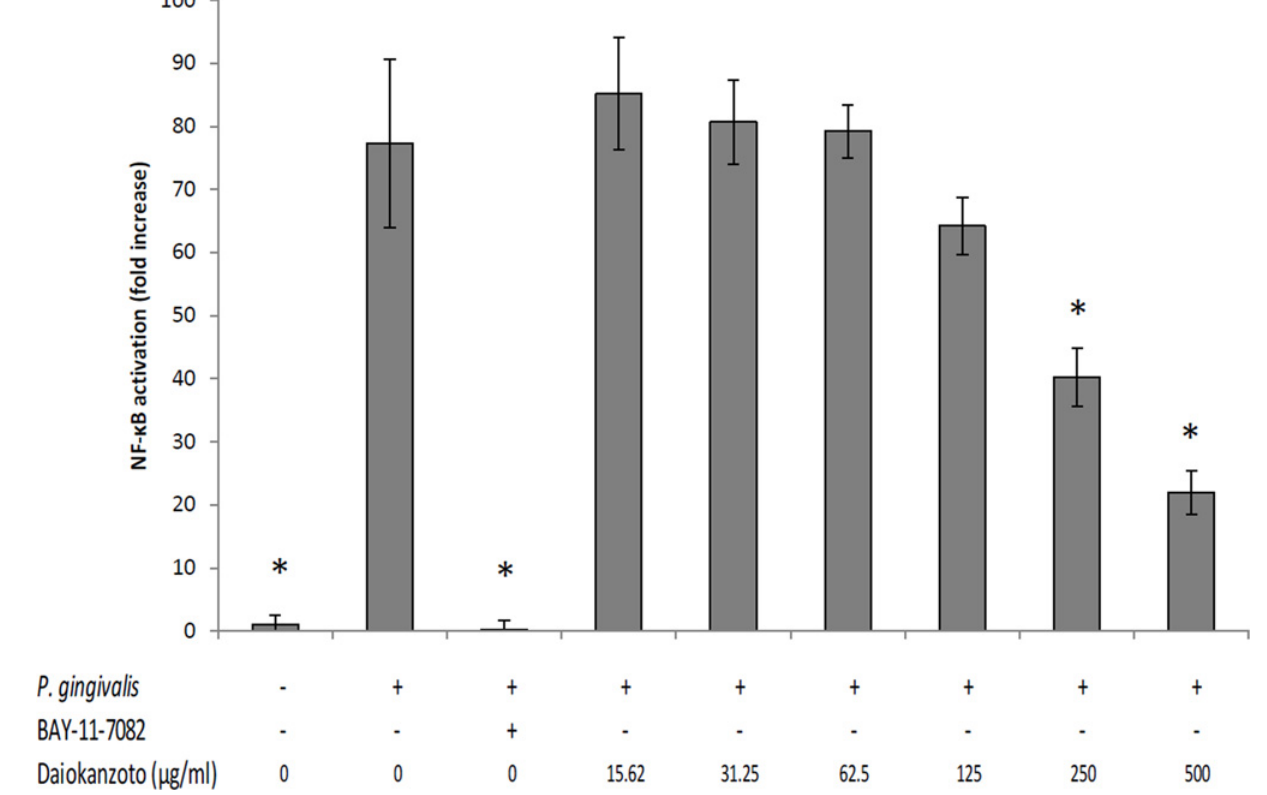
Fig 2. Effect of Daiokanzoto on P . gingivalis -induced activation of the NF- κ B signaling pathway in monocytes. Data are expressed as means ± standard deviations. * , Significant inhibition at p < 0.01 using a Student ’ s t -test. doi:10.1371/journal.pone.0148860.g002 PLOS ONE | DOI:10.1371/journal.pone.0148860 February 9,